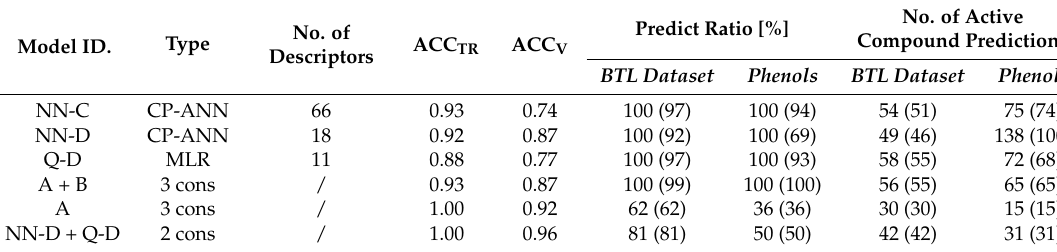
Table 2. Summary of classification models results.